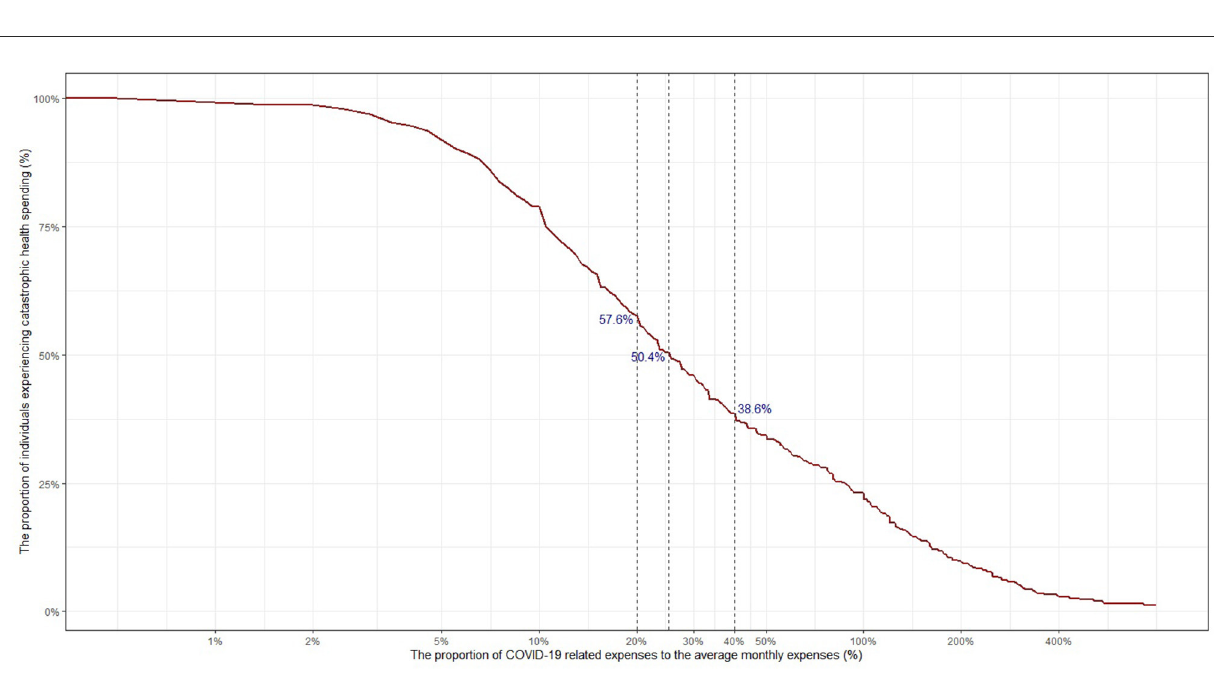
FIGURE2 The proportion of individuals who had out-of-pocket COVID-19 treatments in the past month that experienced catastrophic health